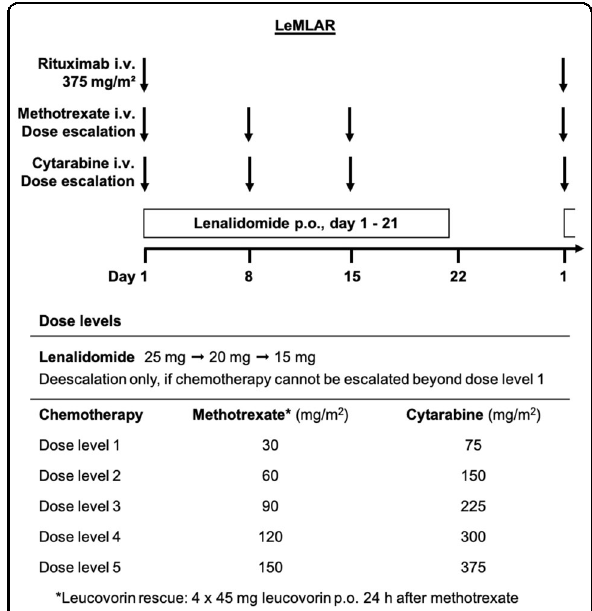
Fig. 1 The LeMLAR protocol. Upper part: Treatment schedule (i.v., intravenous; p.o., per os). Lower part: Dose levels for maximum- tolerated-dose determination and intrapatient dose escalation.